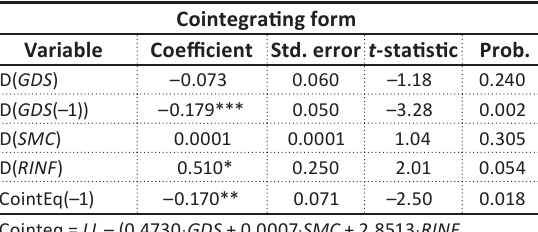
Table 5. Error Correction Model (ECM) for liquid liabilities and growth finance indicators